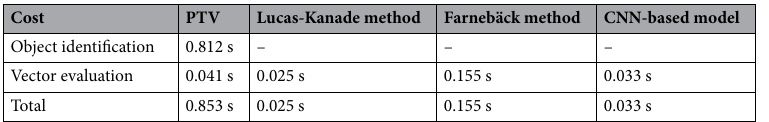
Table 1. Comparison of the computing costs of each method for evaluating the bubble velocities in a single pair of dilute plume images (size of 400 × 608 pixels; see Fig. 7). The PTV and the conventional optical flows are operated by CPU (Intel ® Core™ i7-5960X CPU @3.00 GHz), whereas the CNN-based optical flow uses GPU (GeForce RTX2080 12 GB). It is noted that only the PTV method requires the step of object (bubble)